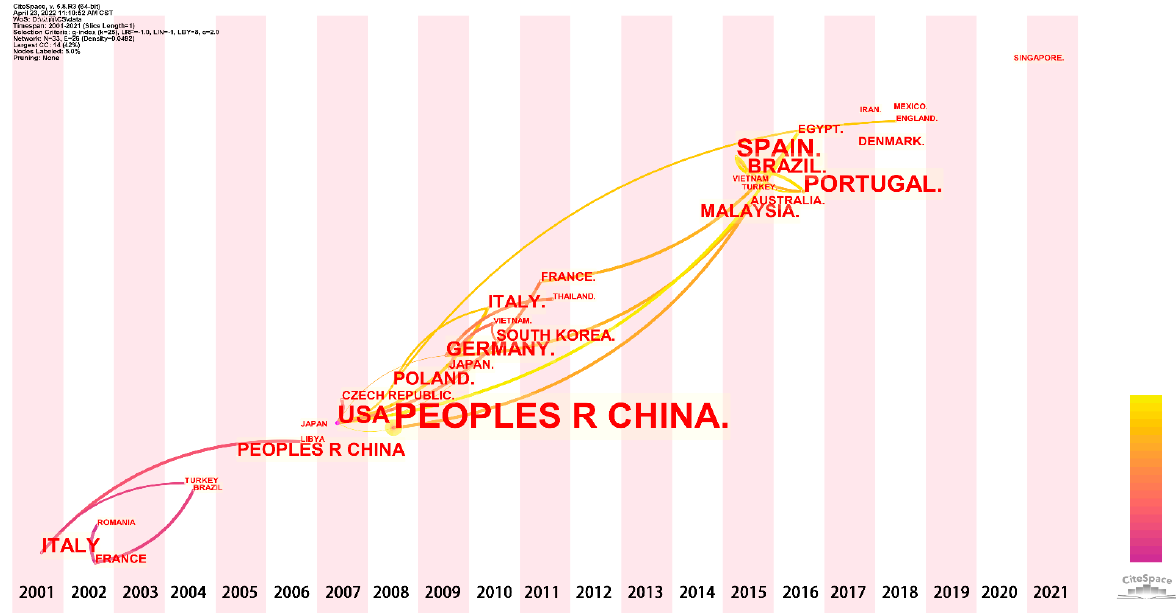
Figure 6. Time-zone view of geographic distribution for electrochemical techniques for detection and analysis of GM crops.